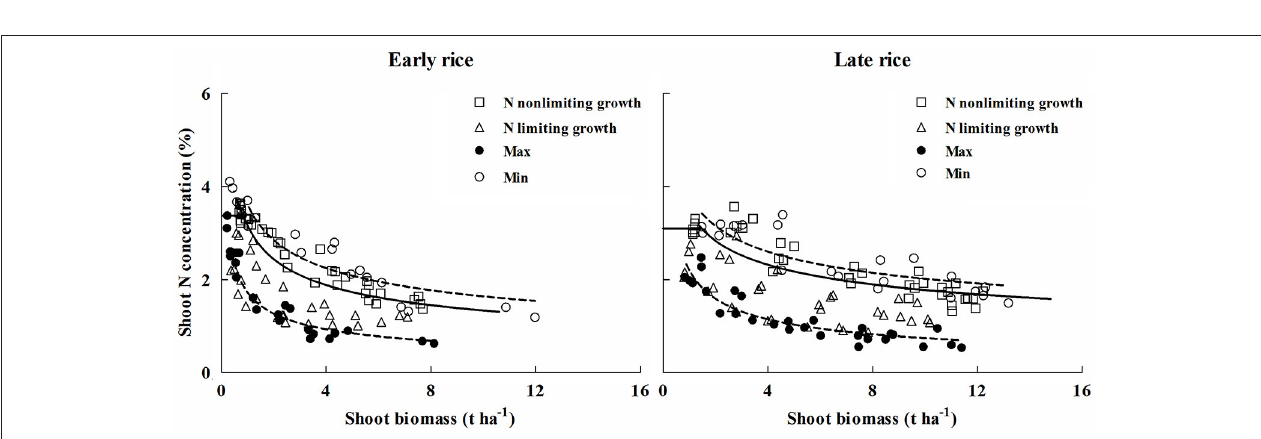
FIGURE 4 | Validation of the N c dilution curves for early rice and late rice. Data points ( (cid:3) ) represent non-N-limiting condition, ( 1 ) represent N limiting condition. The solid line indicates the N c curves (N c = 3.37 W − 0.44 ; N c = 3.69 W − 0.34 ) for early and late rice, respectively, while the dashed lines represent the minimum and maximum N curves, (early rice: N min = 1.72 W − 0.48 , N max = 4.01 W − 0.43 ; late rice: N min = 2.29 W − 0.52 , N max = 4.01 W − 0.31 ). The ( ◦ ) points represent N concentration from highest N rate and the ( • ) points are from zero N rate obtained from Experiments